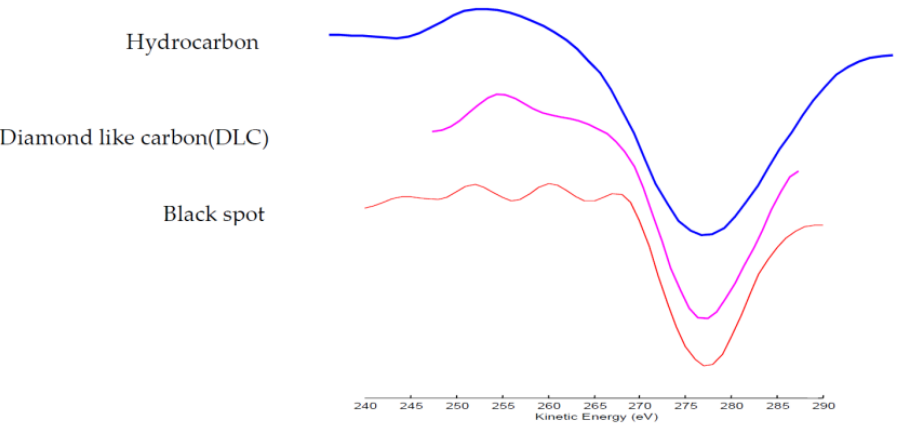
Figure 10. AES fine spectra of different types of carbon.